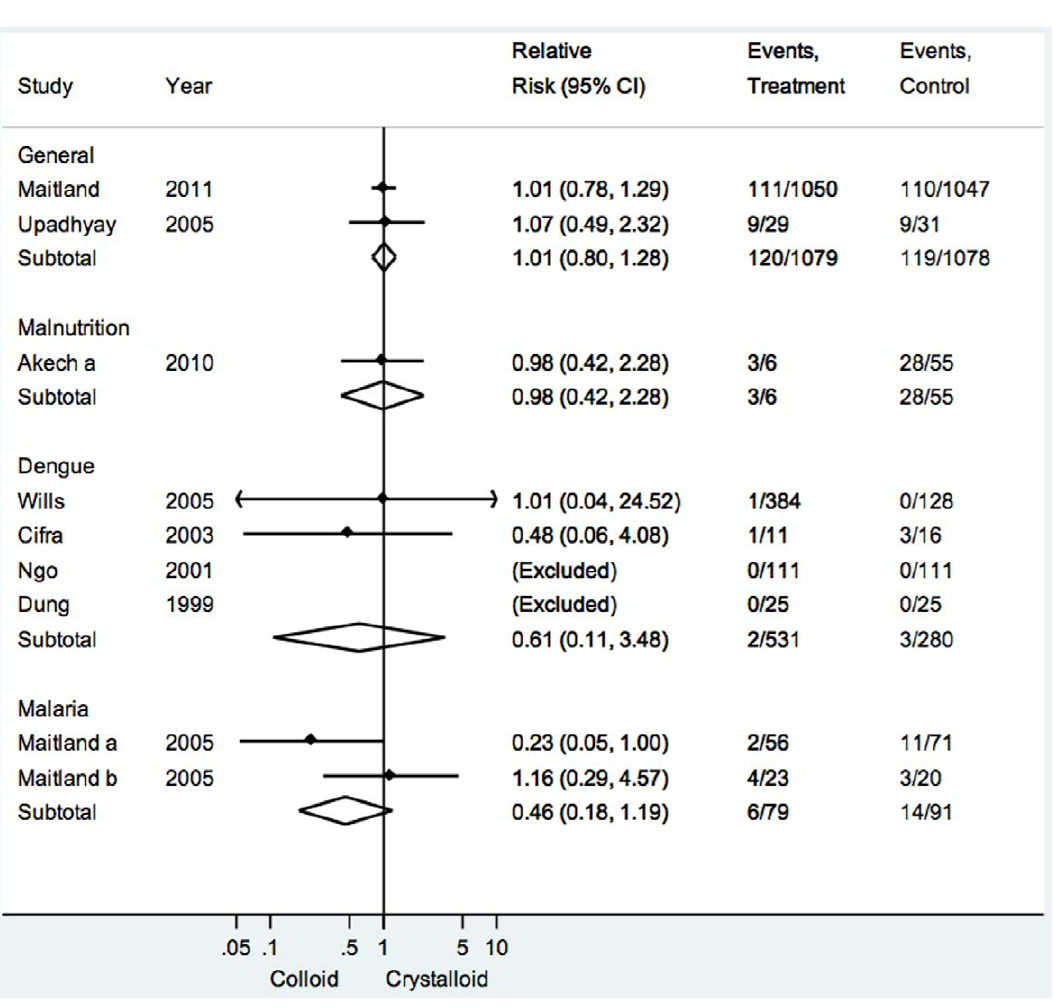
Figure 3. Forest plot for the outcome of mortality comparing colloids and crystalloids.